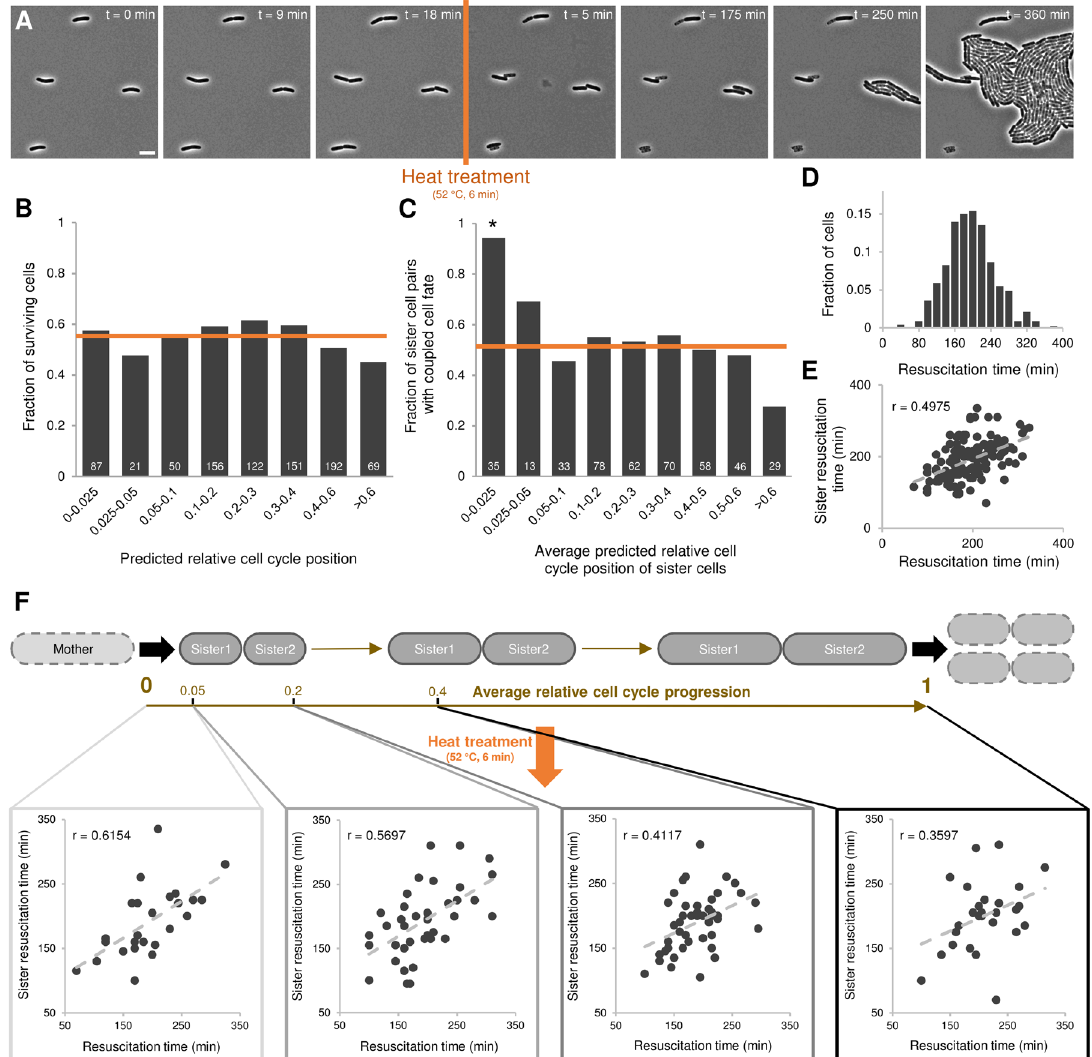
Figure 2. Rapid sibling individualization is also apparent during subsequent outgrowth. ( A ) Representative phase contrast images of a TLFM microscopy image sequence of growing E. coli MG1655 cells at indicated times before and after heat treatment (52 °C, 6 min). The scale bar corresponds to 5 µ m. ( B ) Fraction of cells surviving the heat treatment (52 °C, 6 min) binned by their predicted relative cell cycle position (n = 848). None of the individual bins were found to differ significantly from the average of all cells (orange line, 55.8%, 95% CI = [52.47%, 59.1%]; Fisher’s exact test, α = 0.01; asterisks indicate significant differences). Indicated in white is the total number of cells that was observed for each bin. ( C ) Fraction of sister cells with coupled cell fate (i.e. both cells either survive or die) is binned by the average predicted relative cell cycle position of the siblings (n = 424 sibling pairs). Indicated in white is the total number of sibling pairs that was observed for each bin. Orange line indicates the amount of coupling that would be expected by chance (50.7%, given the overall level of survival), asterisks indicate significant differences (Fisher’s exact test, α = 0.01). Note that the overall empirical fraction of siblings with shared cell fate (54.5%) is not significantly different from what would be expected by chance (p-value = 0.11). ( D ) Resuscitation time distribution of cells surviving the heat treatment (52 °C, 6 min; n = 473). The time individual surviving cells needed to resume growth was determined and binned to create the resuscitation time distribution. ( E ) Correlation between resuscitation times of surviving sister cell pairs (n = 140 sibling pairs, Pearson’s r = 0.4975, p-value = 1.04 × 10 − 9 ). ( F ) Evolution of the correlation between surviving siblings’ resuscitation times as these cells progress through their cell cycle. Shown is a schematic of two sibling cells progressing through their corresponding cell cycles. Depending on the timing of the heat treatment (orange arrow), with respect to the relative cell cycle progression of these cells, the correlation of their corresponding resuscitation times (in the case both siblings were able to survive) diminishes as cells advance. Correlations are shown for different cell cycle progression intervals (0–0.05, 0.05–0.2, 0.2–0.4 and 0.4–1, respectively) based on the average predicted relative cell cycle position of surviving siblings (n = 25, 38, 48 and 28 sibling pairs, respectively). Both the strength (respective Pearson’s r-values: 0.6154, 0.5697, 0.4117 and 0.3597, respective bootstrapped 95% CI: [0.3692, 0.8222], [0.3813, 0.7232], [0.1495, 0.6377] and [ − 0.0364, 0.6947]) and the significance (respective p-values: 4.78 × 10 − 4 , 1.9 × 10 − 4 , 5.49 × 10 − 3 and 5.83 × 10 − 2 ) of these correlations decline gradually as surviving siblings progress through their cell cycle before the heat treatment (52 °C, 6